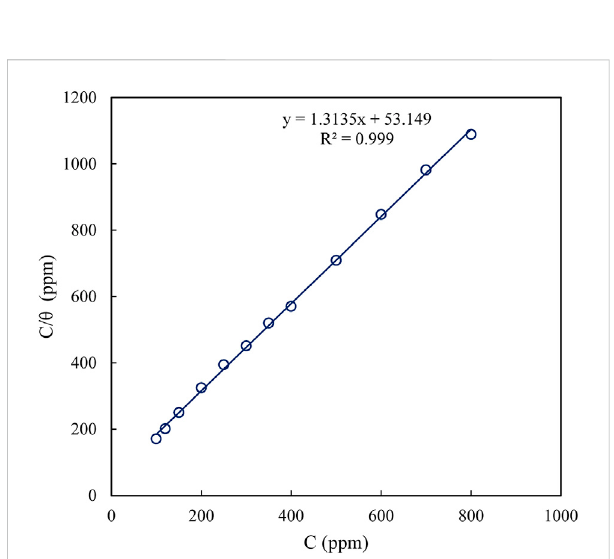
FIGURE 5 Langmuir adsorption isotherm model for polyacrylamide-okra graft at 25 °